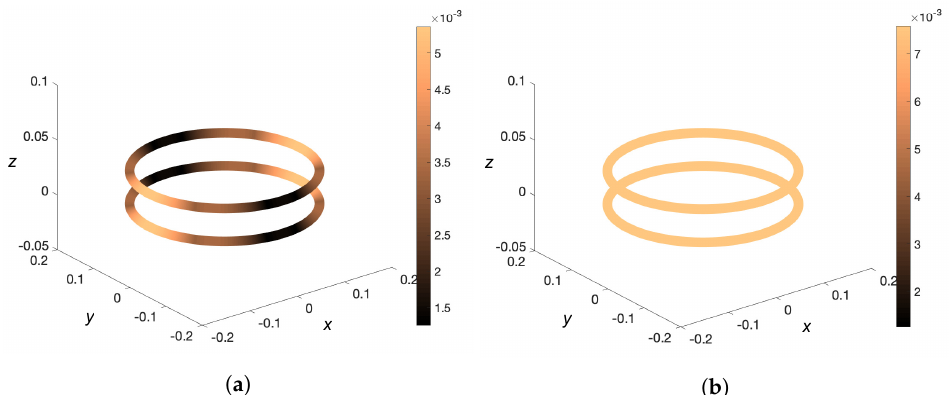
Figure 4. Plot of the centerline difference acting thin tori of radius (cid:101) = 0.01, stacked in the z -direction at a distance 0.01 from each other. The fibers in ( a ) are subject to the constant force f = e x and have a maximum difference of 0.0054. The fibers in ( b ) are subject to the force f = e z and have a maximum difference of